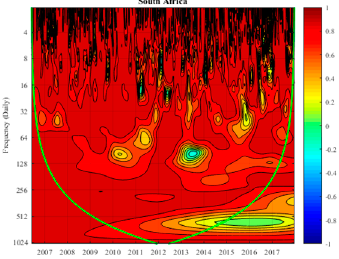
Figure A3. Islamic-conventional stock returns Wavelet correlations for African region’s markets.